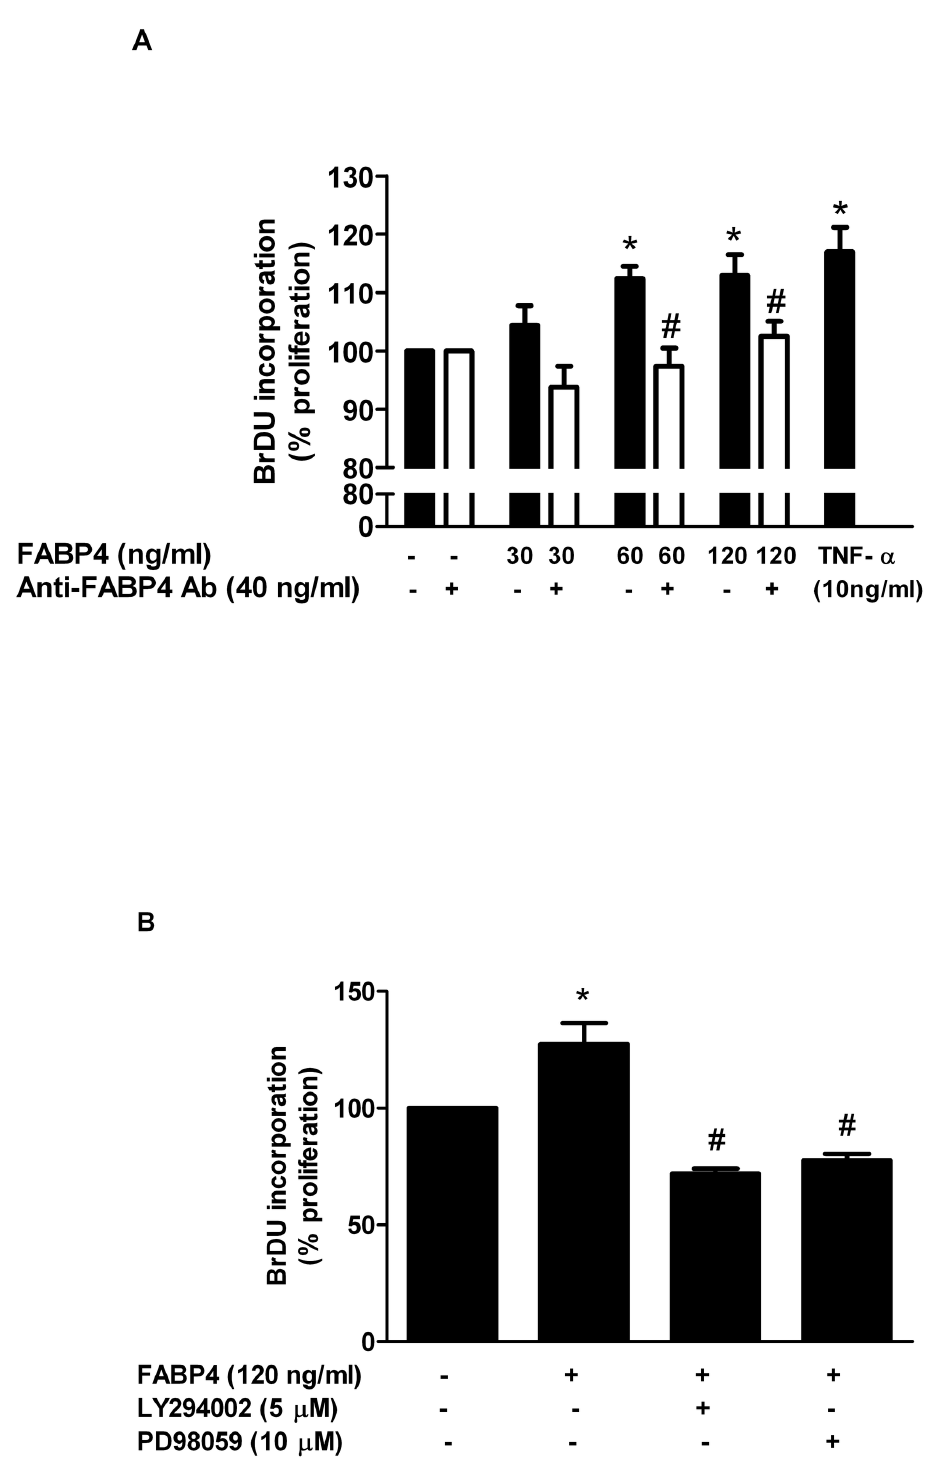
Figure 1. Effect of FABP4 on HCSMCs proliferation as assessed by BrdU incorporation. (A) Effect of FABP4 (30-120 ng/ml) with and without anti-FABP4 antibody (40 ng/ml) on the proliferation HCASMCs at 24 h. TNF-α (10 ng/ml) was used as a positive control. (B) Effect of LY294002 (5 µM) and PD98059 (10 µM) on FABP4 (120 ng/ml)-induced HCASMCs proliferation at 24 h. The results are expressed as the mean ± SEM of three experiments run in quadruplicate. *p<0.05 vs unstimulated cells; #p<0.05 vs FABP4-stimulated cells. doi: 10.1371/journal.pone.0081914.g001 PLOS ONE |